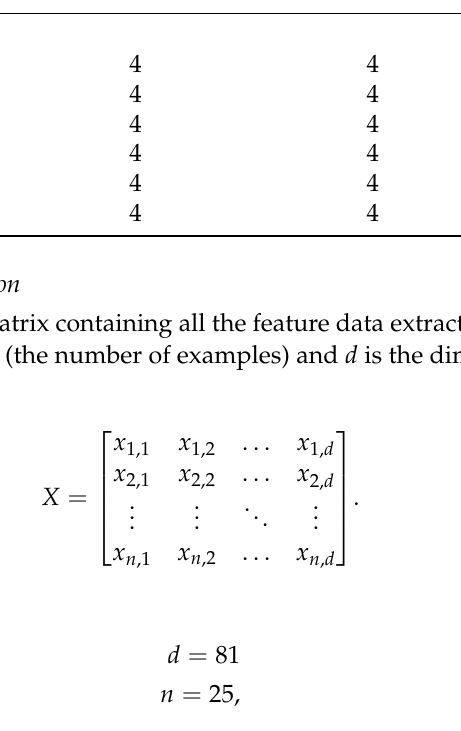
Table 1. Cont. On Accelerometer On Gyroscope Between Both Split signal window Correlation coefficient